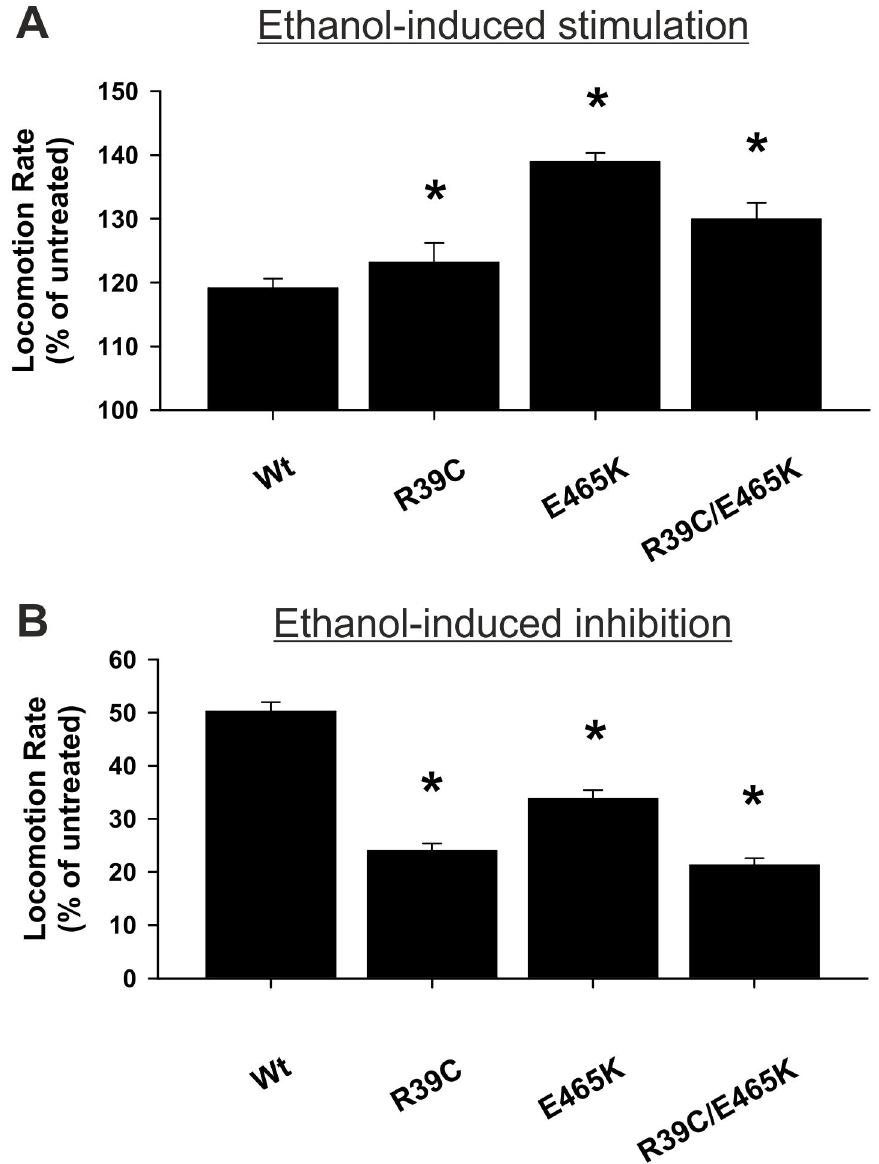
Figure 2. The phenotypic effects of unc-18 R39C and E465K in alcohol sensitivity are not additive. Null unc-18 ( e81 ) worms were rescued transgenically with wild-type (Wt) unc-18 or unc-18 with the indicated point mutations. In comparison to Wt unc-18 , all three mutants had an increase in acute sensitivity to ethanol at (A) stimulatory levels (21 mM) and (B) depressive levels (400 mM) of external ethanol. For (A) significance was assessed by Kruskal-Wallis one-way analysis of variance with post-hoc comparisons; *P<0.05; N = 15 (Wt), 15 (R39C), 15 (E465K) and 15 (R39C/E465K). For (B) significance was assessed by one-way analysis of variance with post-hoc comparisons; *P<0.05; N = 15 (Wt), 15 (R39C), 15 (E465K), 15 (R39C/E465K). doi: 10.1371/journal.pone.0081117.g002 R39C/E465K double mutant in comparison to the single R39C enhancement in alcohol-dependent stimulation by either single mutation was also apparent in the lof rab-3 background (one- (R39C or E465K) or double (R39C/E465K) mutations of way analysis of variance with post-hoc comparison; P<0.05; N unc-18 , however, was negated when these mutations were = 30 (R39C), 30 (E465K) and 30 (R39C/E465K)). expressed in the lof rab-3 mutant background. As previously In response to low levels of alcohol, lof rab-3 worms described [9], at depressive concentrations of ethanol lof rab-3 exhibited a normal stimulation of locomotion (Figure 4A). The ( y250 ) worms were less sensitive than Bristol N2 wild-types